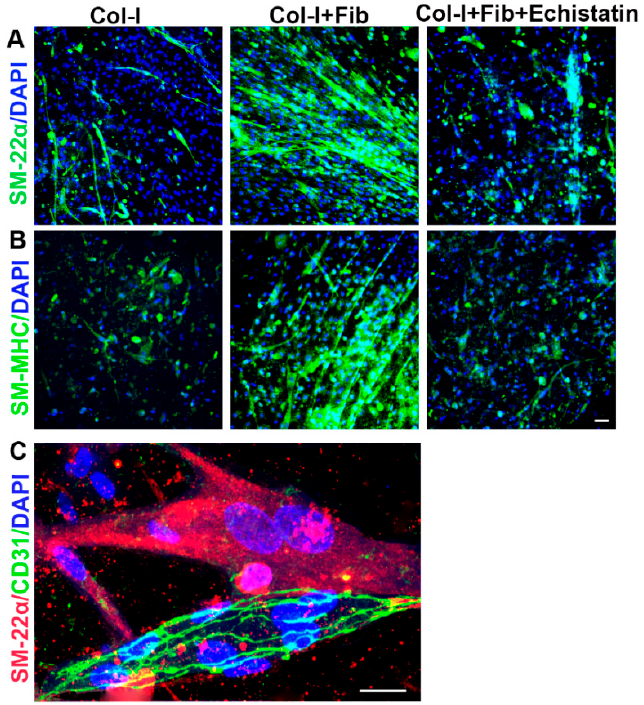
Figure 5. Characterization of cell phenotype embedded in the co-culture hydrogels of hiPSC-VSMC and HUVEC. Phenotype assessment of hiPSC-VSMCs embedded in the hydrogels. Immunofluo- rescence images showing ( A ) SM-22 α (Green), and ( B ) smooth muscle myosin heavy chain (Green) stained hiPSC-VSMC in the co-culture hydrogels. The groups were collagen hydrogel (Col-I), fi- bronectin functionalized collagen hydrogels (Col-I + Fib), and echistatin treated Col-I + Fib hydro- gels (Col-I + Fib + Echistatin). Dapi (Blue) was used to stain nuclei. Scale bar measures 50 µm. ( C ) Representative immunofluorescence images showing staining of both hiPSC-VSMC and HUVEC with SM-22 α (Red) and CD31 (Green), respectively, in a Col-I + Fib hydrogel. Dapi (Blue) was used to stain nuclei. Scale bar measures 20 µm.